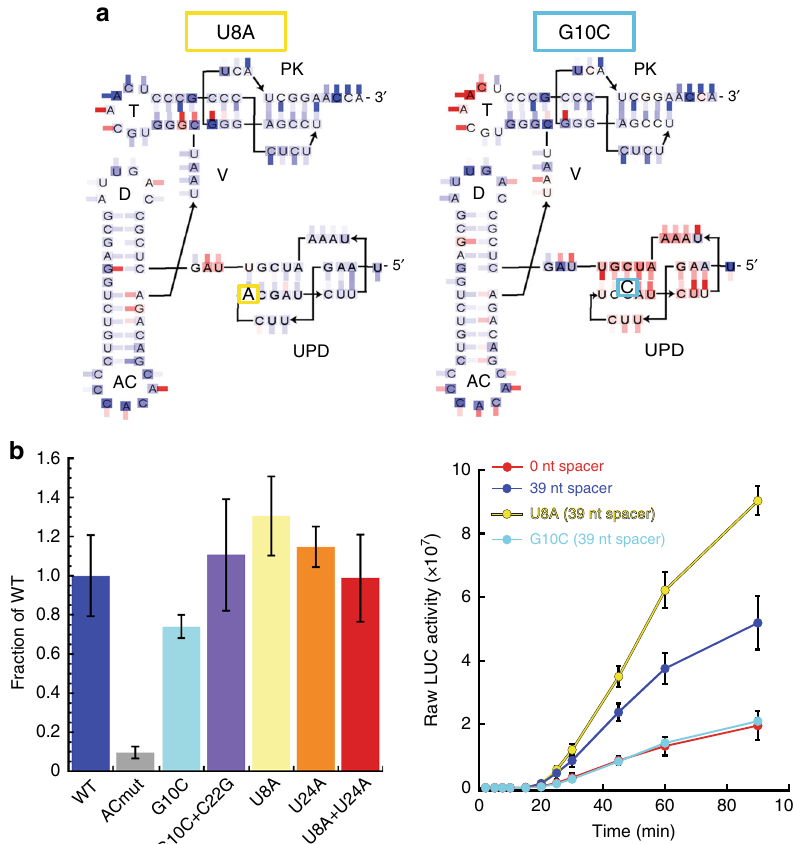
Fig. 4 Functional coupling between RNA domains. a Secondary structures of the U8A and G10C mutants, colored to re fl ect the difference in chemical probing between mutant and WT. The new secondary structure is derived from the x-ray crystal structure (see refs. 9,36 for previously predicted secondary structures). Base shading represents NMIA probing and tick marks represent DMS or CMCT probing, colored as in Fig. 3b. b Left: in vitro valylation assay comparing mutants U8A, U24A, the double mutant U8A + U24A, G10C, and the compensatory mutant G10C + C22G to WT and a mutant with altered anticodon loop (ACmut) to inhibit valylation. Right: Translation assay comparing the U8A and G10C mutants to WT RNA reporters used to mimic the gRNA (blue) and sgRNA (red). Error bars represent one s.e.m. of n ≥ 3